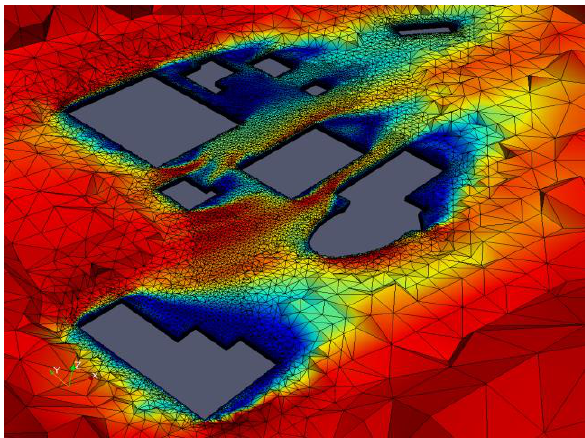
Figure 4. Crinkled cross-section of the case 12 mesh overlayed with the converged wind field at a height 2m above